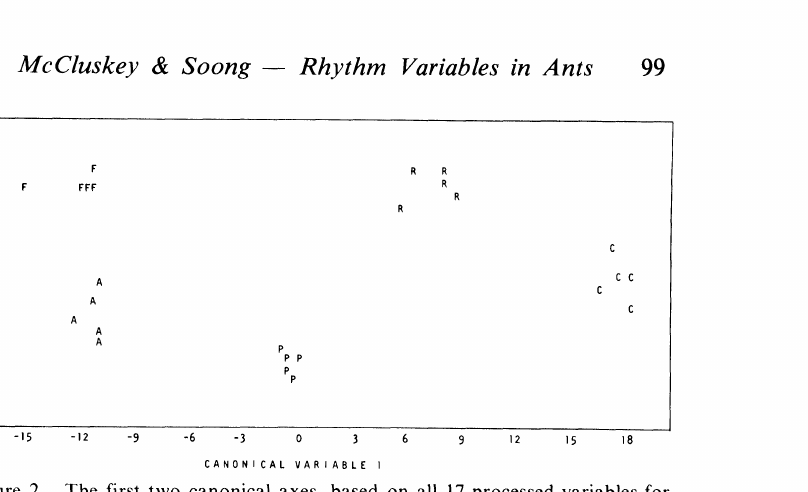
Figure 2. The first two canonical axes, based on all 17 processed variables for which every one of the 25 cases (5 species 5 replicates) was represented, and for which (phase variables) distribution was across few enough hours to assume linearity. The first axis represents the greatest possible difference between species, and the second, the greatest remaining difference orthogonal to the first. Output from the BMDP7M program, run so as to bypass the stepwise feature (as recommended by Pimentel and Frey, 1978). A V. andre# C P. calfornicus; F F. pilicornis; P-- V. per.gandei; R- P.